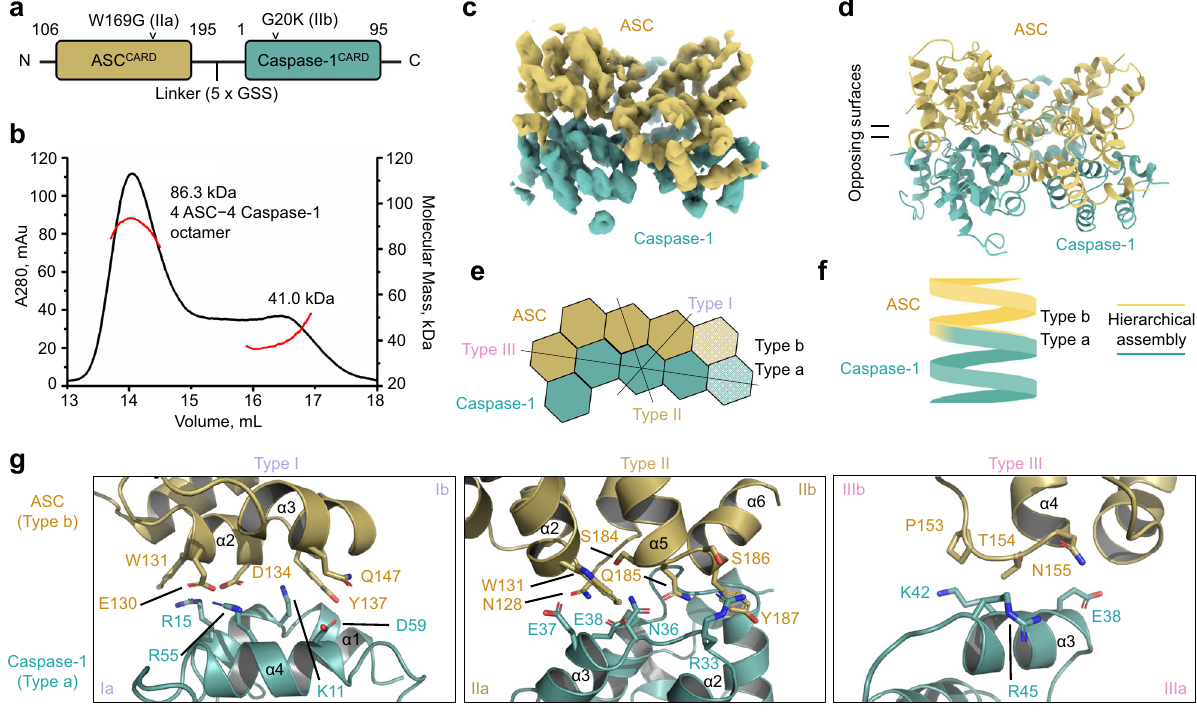
Fig. 5 Puri fi cation and structure determination of an ASC CARD − caspase-1 CARD octamer. a Construct design of ASC CARD (brown) and caspase-1 CARD (turquoise) linked by 5× GSS linker. b MALS data for the ASC CARD − caspase-1 CARD complex, with a molecular mass of 86.3 kDa corresponding to a complex formed by four subunits of ASC CARD and four subunits of caspase-1 CARD . c Cryo-EM density of the ASC CARD − caspase-1 CARD octamer at 3.9 Å resolution in which a layer of ASC CARD (gold) is located on top of a caspase-1 CARD layer (green). d Model of the ASC CARD – aspase-1 CARD octamer. e Schematic diagram of the octamer complex with depicted interfaces. There are three type I interactions, four type II interactions, and one type III interaction between ASC and caspase-1. f Simpli fi ed illustration of ASC and caspase-1 hierarchy in in fl ammasome signaling. g Zoom-ins of type I, II, and